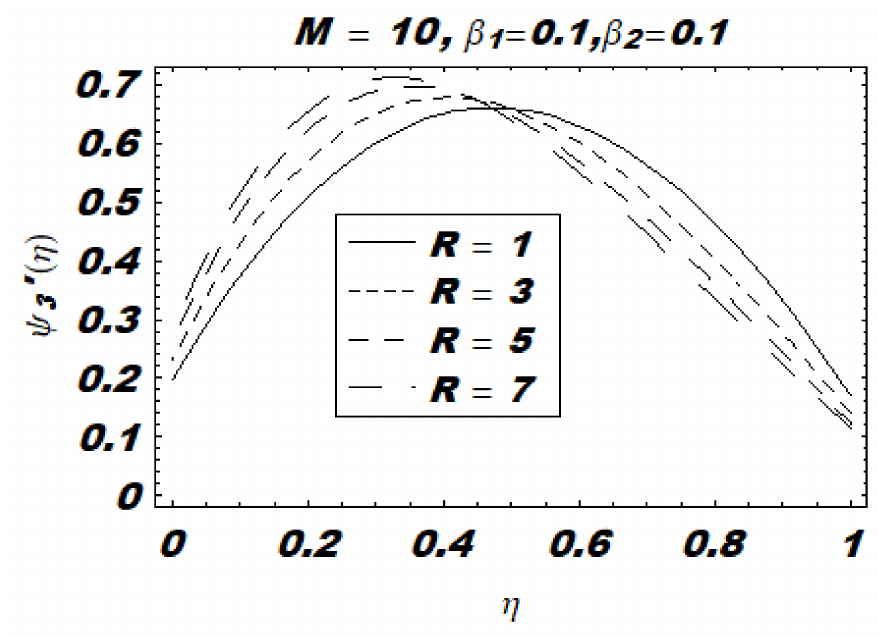
Figure 21. Similarity function ψ /